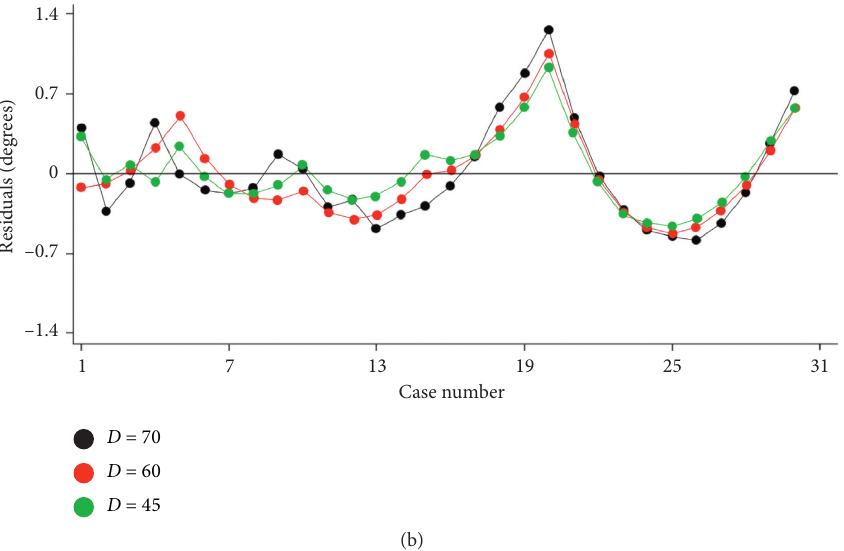
Figure 4: Residuals of the data of various columns from Raimondi’s tables regarding their respective regression curves.